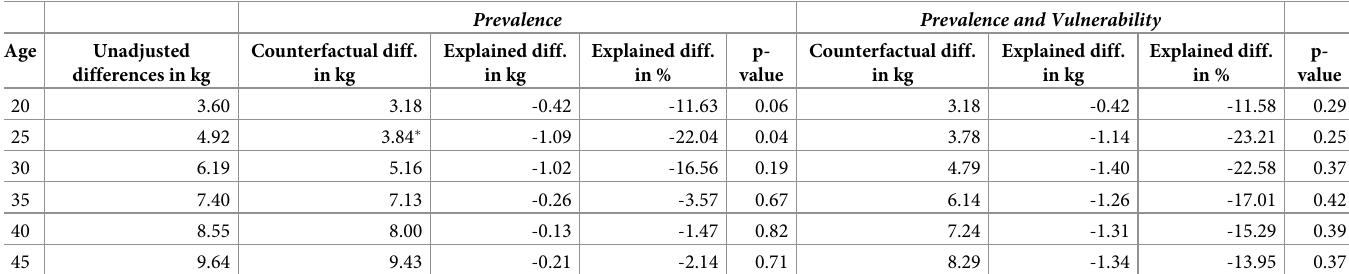
Data are from SOEP v.34; own calculations; “Unadjusted differences” indicate estimated differences between lower and higher educated women at different ages based on model M1 for weight; “Counterfactual differences” indicate absolute size of the differences between lower and higher educated women based on model M3